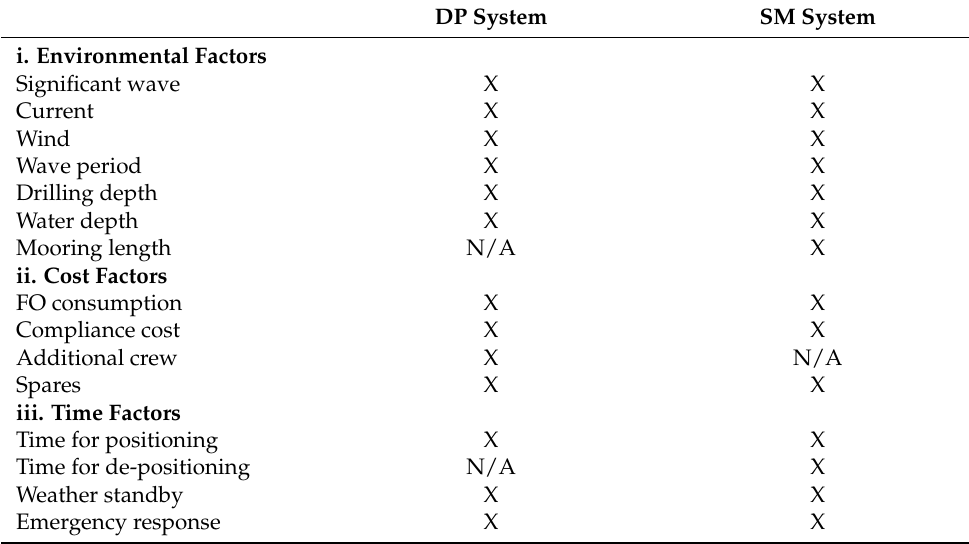
Table 1. Identified variables for DP and SM